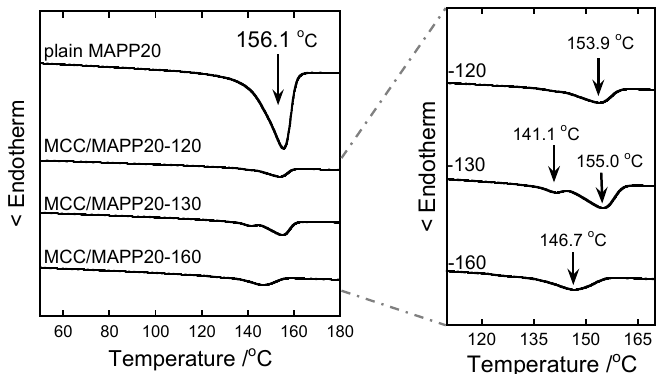
Figure 7. DSC thermogram (second heating scan) of MCC/MAPP20 binary composites prepared at various kneading temperatures. The right panel is an enlarged view of thermograms for the endothermic temperature range of the three MCC/MAPP20 composites.